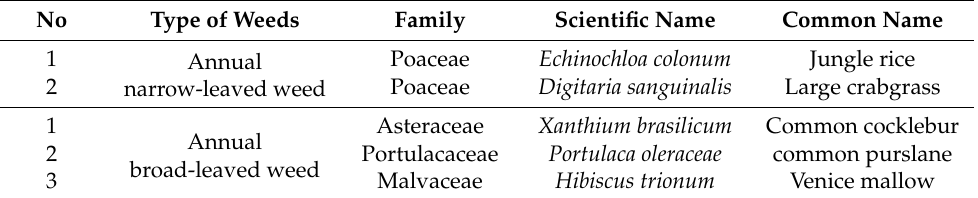
Table 2. Family, scientific, and common names of weeds registered in the peanut field during the 2018 and 2019